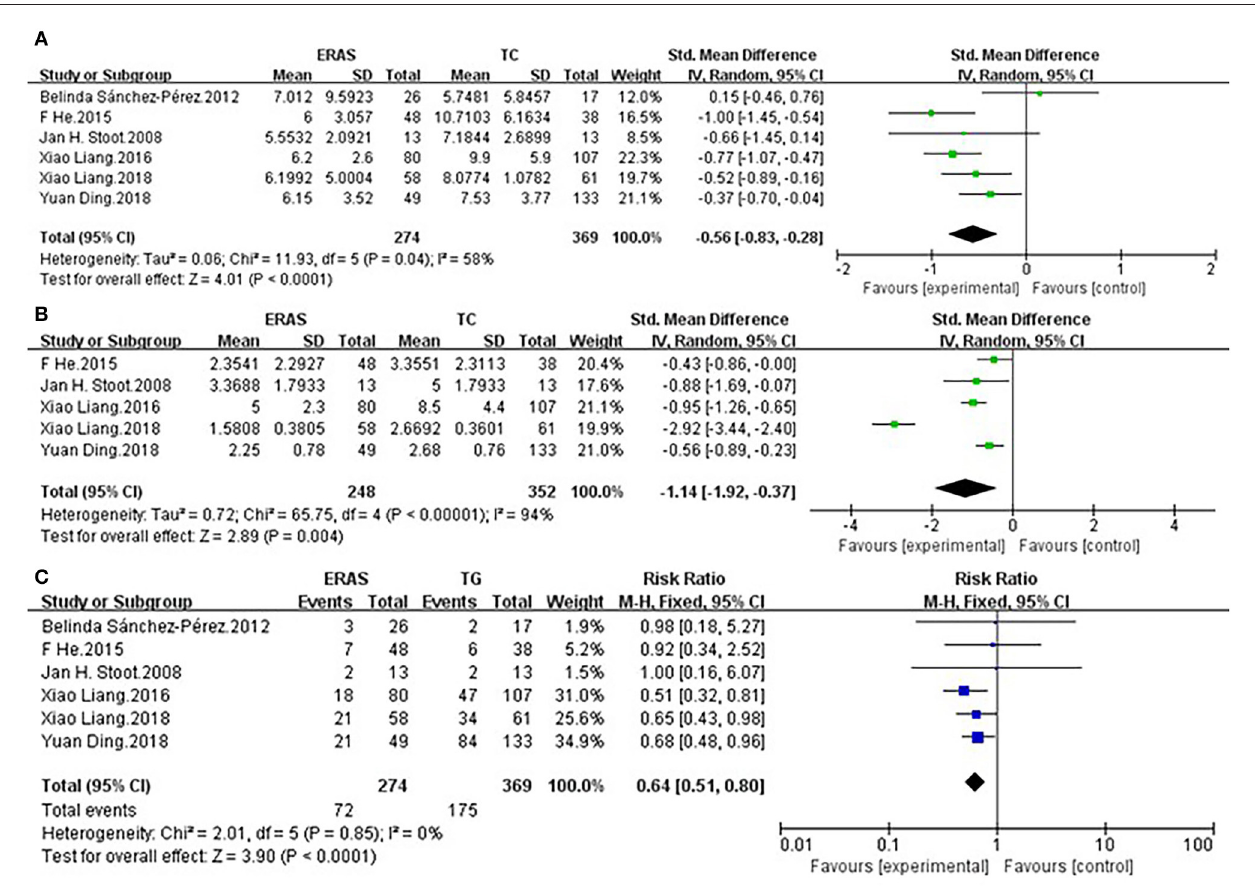
FIGURE 2 | Comparisons of primary outcomes after enhanced recovery after surgery (ERAS) or traditional care (TC) in patients undergoing laparoscopic hepatectomy. The differences in (A) length of hospital stay (LOS), (B) duration to functional recovery, and (C) overall postoperative complication rate.